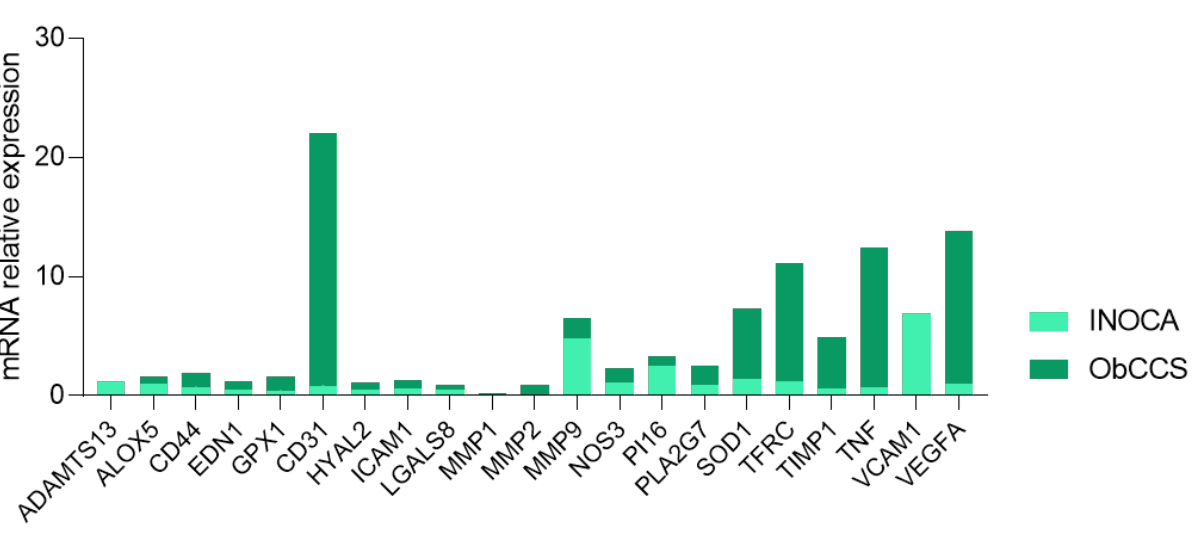
Figure 1. Histogram showing expression of pooled PBMC-cDNAs of INOCA ( n = 10) and ObCCS ( n = 10) patients. INOCA = ischemia with non-obstructive coronary artery; ObCCS = obstructive chronic coronary syndrome; PBMC = peripheral blood mononuclear cell; ADAMTS13 = ADAM Met- allopeptidase with Thrombospondin Type 1 Motif 13; ALOX5 = Arachidonate 5-Lipoxygenase; CD31 = Platelet And Endothelial Cell Adhesion Molecule 1; CD44 = Hyaluronan receptor; EDN1 = Endothelin 1; GPX1 = Glutathione peroxidase 1; HYAL2 = Hyaluronidase 2; ICAM1 = Intercellular Adhesion Molecule 1; LGALS8 = Galectin 8; MMP1 = Matrix metalloproteinase 1; MMP2 = Matrix metalloproteinase 2; MMP9 = Matrix metalloproteinase 9; NOS3 = Endothelial nitric oxide synthase; PI16 = Peptidase Inhibitor 16; PLA2G7 = Phospholipase A2 Group VII; SOD1 = Superoxide dis- mutase 1; TFRC = Transferrin Receptor; TIMP1 = TIMP Metallopeptidase Inhibitor 1; TNF = Tumor Necrosis Factor; VCAM1 = Vascular cell adhesion molecule 1; VEGFA = Vascular endothelial growth factor A.